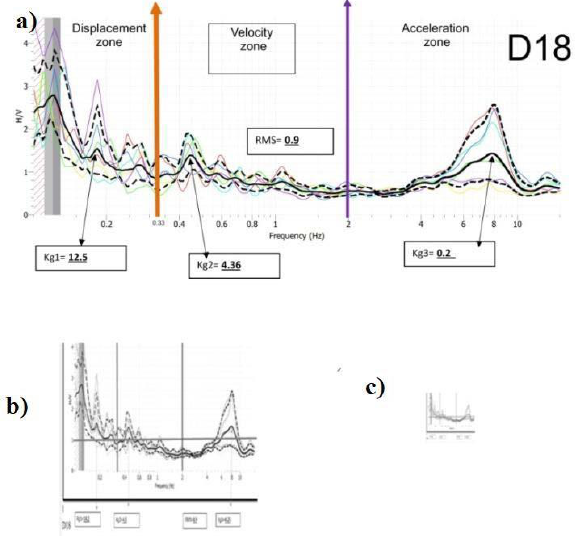
Figure 5. A selected station named as D18